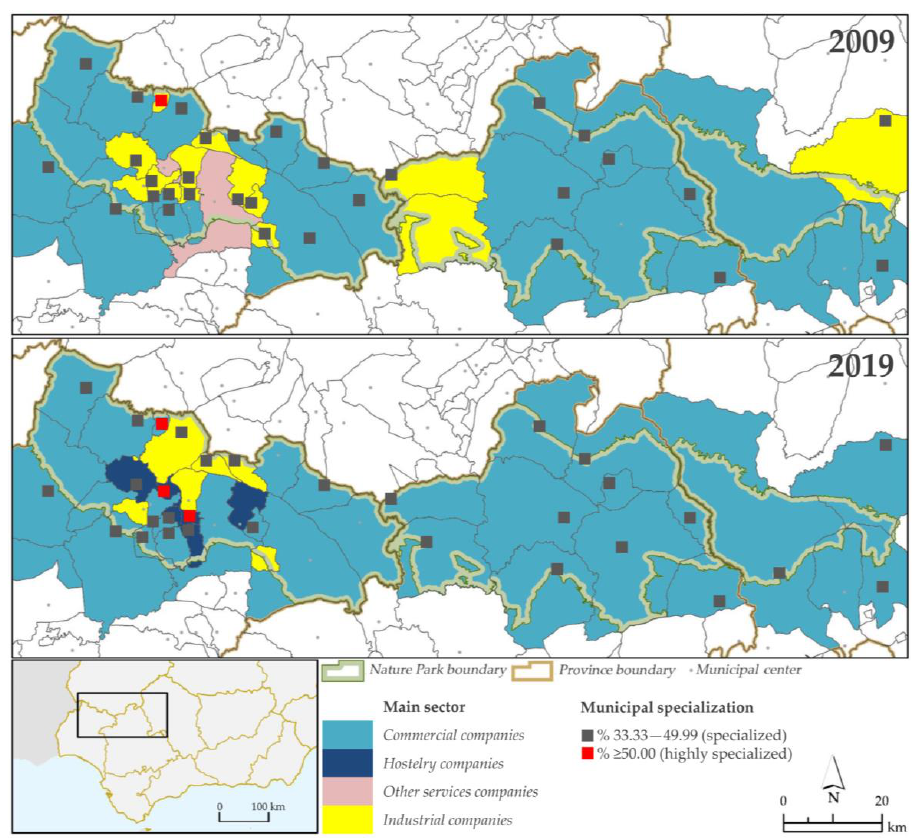
Figure 11. Companies by central activity sector (excluding agriculture) in 2009 and 2021. Source: [85]; authors ’ elaboration.